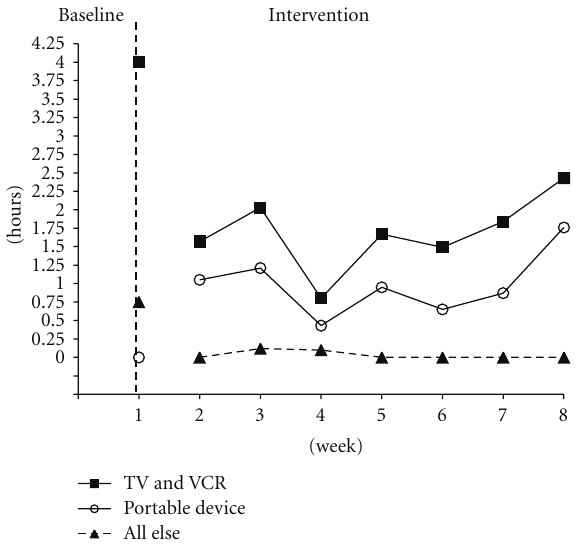
Figure 1: Child 1 averaged weekly media use by form over time.